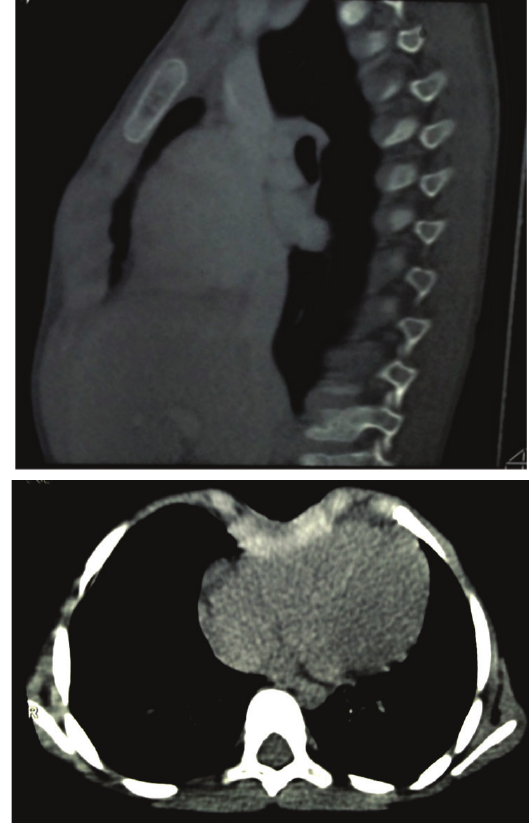
Figure 6 a-b: At the follow up after 1 year the patient had a normal looking chest wall with good integration of the extracellular matrix with surrounding tissues as shown to chest X-ray and CT images.